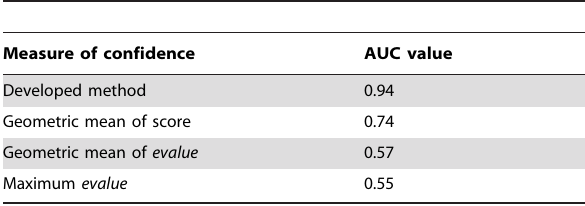
Table 1. Performance evaluation of approach used to predict PPI